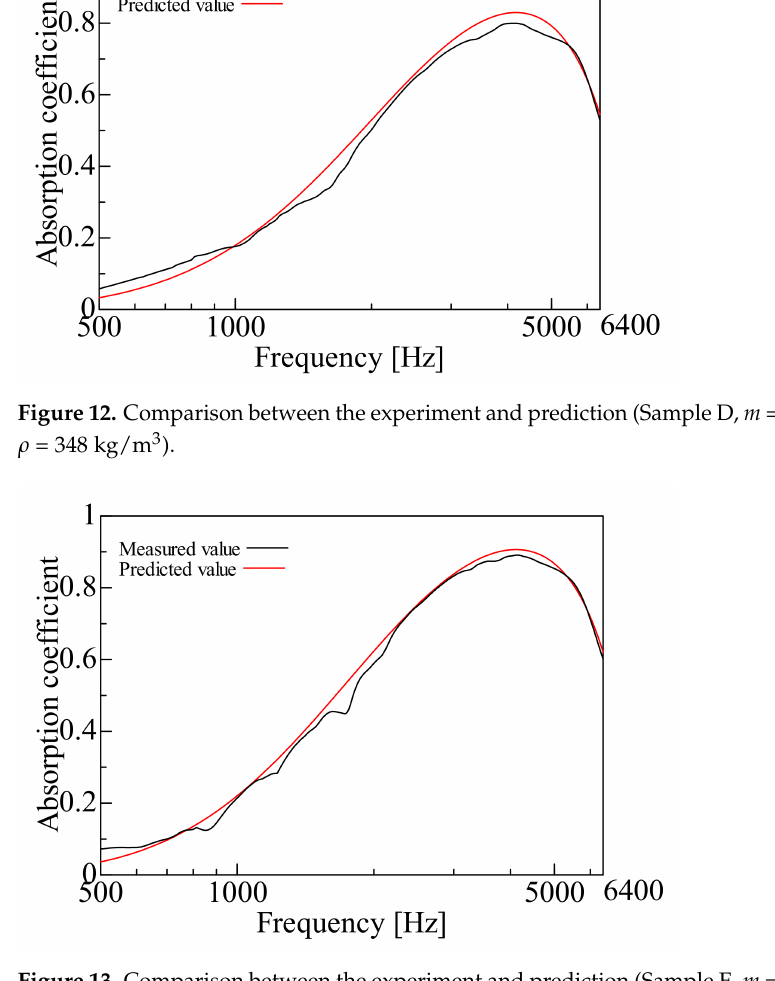
Figure 13. Comparison between the experiment and prediction (Sample E, m = 0.30 g/m 2 , t = 230 µ m, ρ = 349 kg/m 3